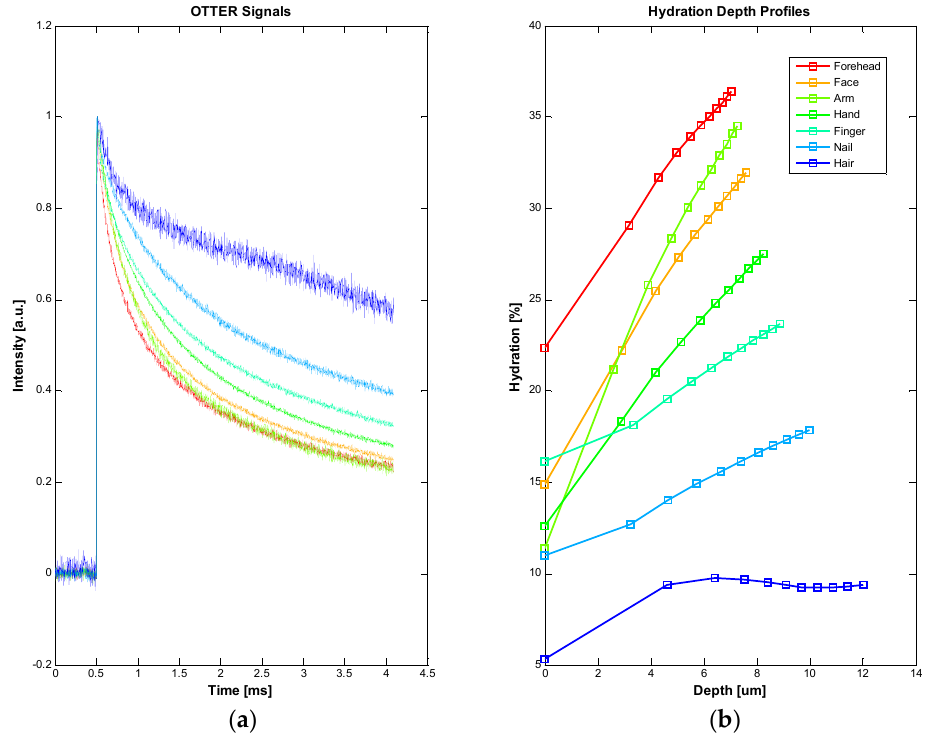
Figure 4. The typical OTTER signals of different skin sites, including hair and nail ( a ), and the corresponding water concentration depth profiles using SLS fitting technique ( b ).